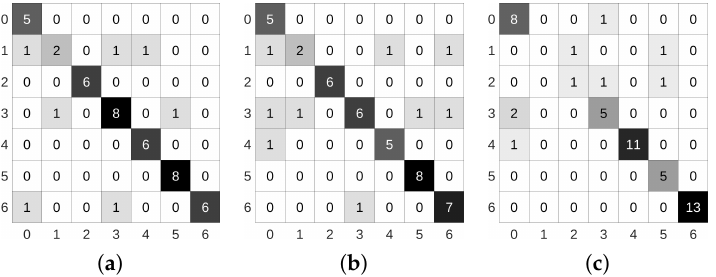
Figure 19. LSTM results using KITTI360 dataset and RGB data ( a ), MBEVs ( b ), and Alcalá-1 RGB dataset ( c ).